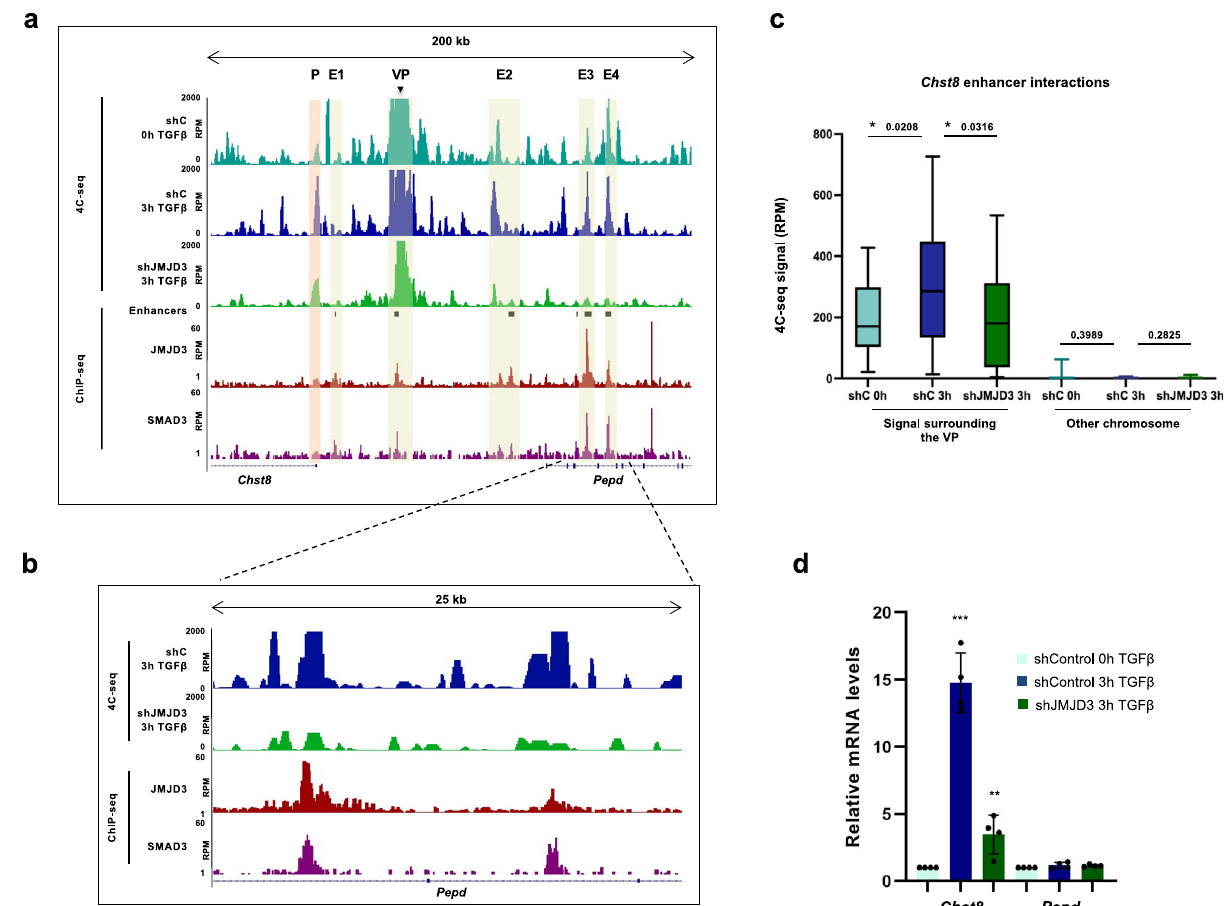
Fig. 3 TGF β -mediated enhancer-cluster assembly depends on JMJD3. a UCSC Genome Browser captures show 4C-seq pro fi les spanning 200 kb around the VP enhancer (black arrow) in NSCs untreated or treated (3 h) with TGF β . ChIP-seq signals of SMAD3 and JMJD3 upon TGF β stimulation (0.5 and 3 h, respectively) are shown. The location of the members of the EC is also indicated with yellow boxes. b Capture showing a zoom into a region where TGF β - induced contacts are lost in JMJD3-depleted (shJMJD3) NSCs. c Boxplot displays the averaged values obtained from two biological independent